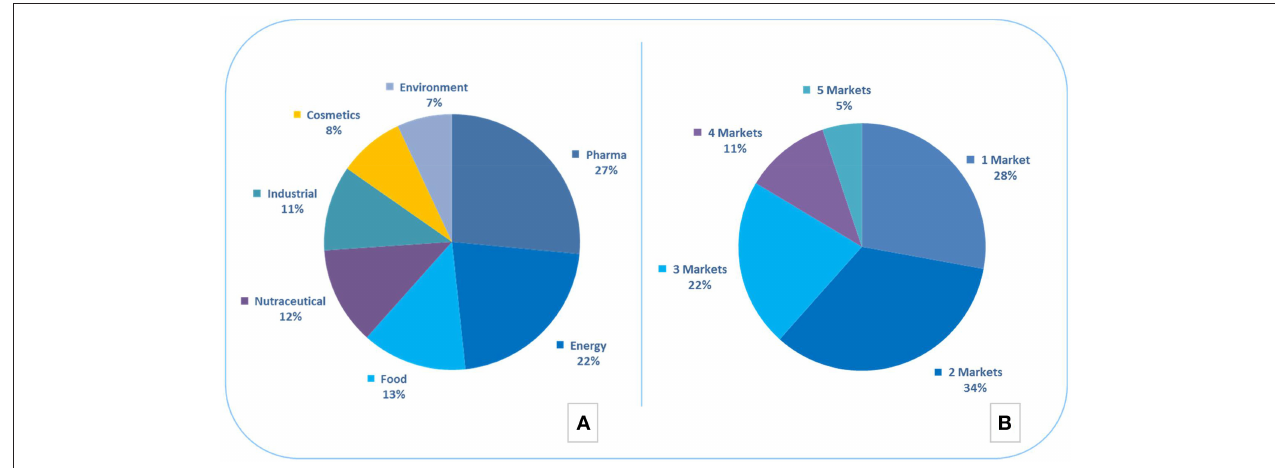
FIGURE 4 | The markets served ( n = 445 ). (A) Represents the first market served by the firms (%). In (B) it is described the number of markets served by each organization.